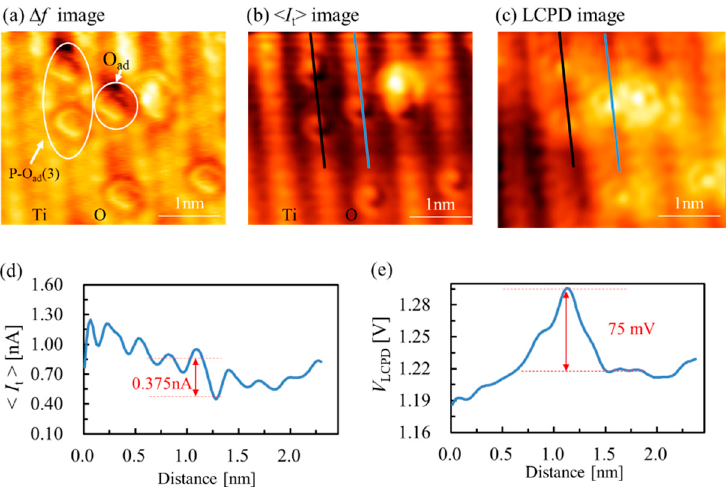
Figure 5. Multiple images of TiO 2 (110) surface with atomic resolution and corresponding line profiles. ( a ) Frequency shift ( ∆ f ) image, ( b ) tunneling current (< I t >) image and ( c ) local contact potential difference ( V LCPD ) image. ( d , e ) The line profiles along the blue line on the surface in (b,c). ( f 0 = 805 kHz, Q = 27623, ∆ f = − 260 Hz, V DC = 1.3 V, V AC = 1.5 V, A = 500 pm, size: 3.5 × 3.2 nm 2 ).